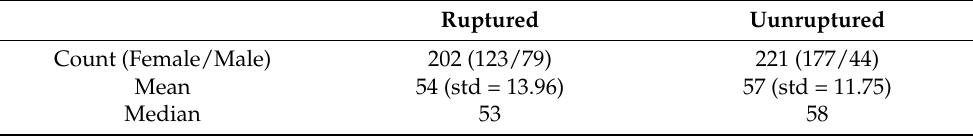
Table 1. Comparison of age in the ruptured and unruptured